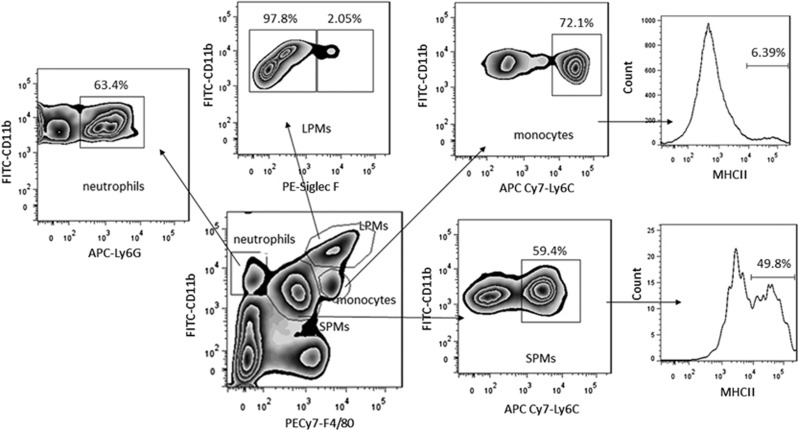
Gating of macrophages/monocytes/neutrophils subsets in peritoneal exudates. Cells collected from the peritoneal cavity were stained with appropriate anti-mouse mAbs, and analyzed by flow cytometry. It showed four subsets in the peritoneal cells gated in CD19− population: CD11bhigh F4/80high CD11clow in large size (LPMs), CD11bint F4/80int LY6Cint CD11c−/low MHC II high in small size (SPMs), CD11bint LY6Chigh MHC II low CD11c−/low (monocytes), CD11bint F4/80− LY6Ghigh (neutrophils)